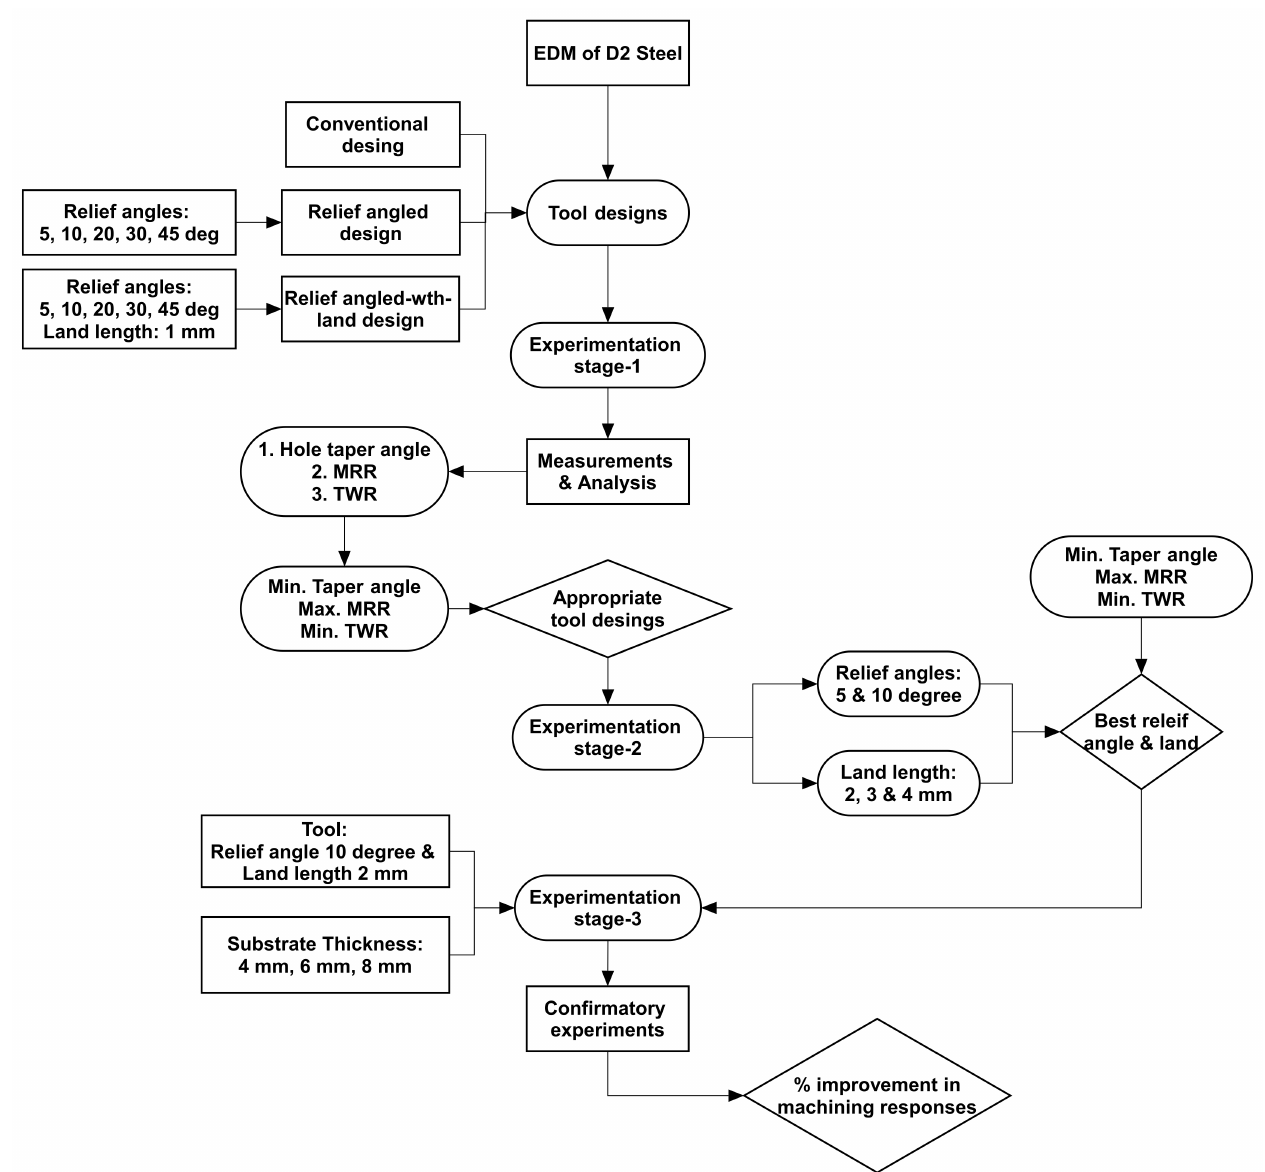
Figure 2. Research methodology adopted for experimentation on D2-steel through